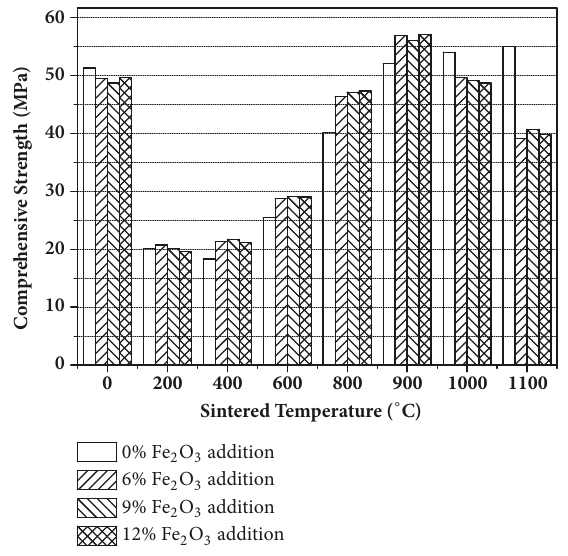
Figure 2: Comprehensive